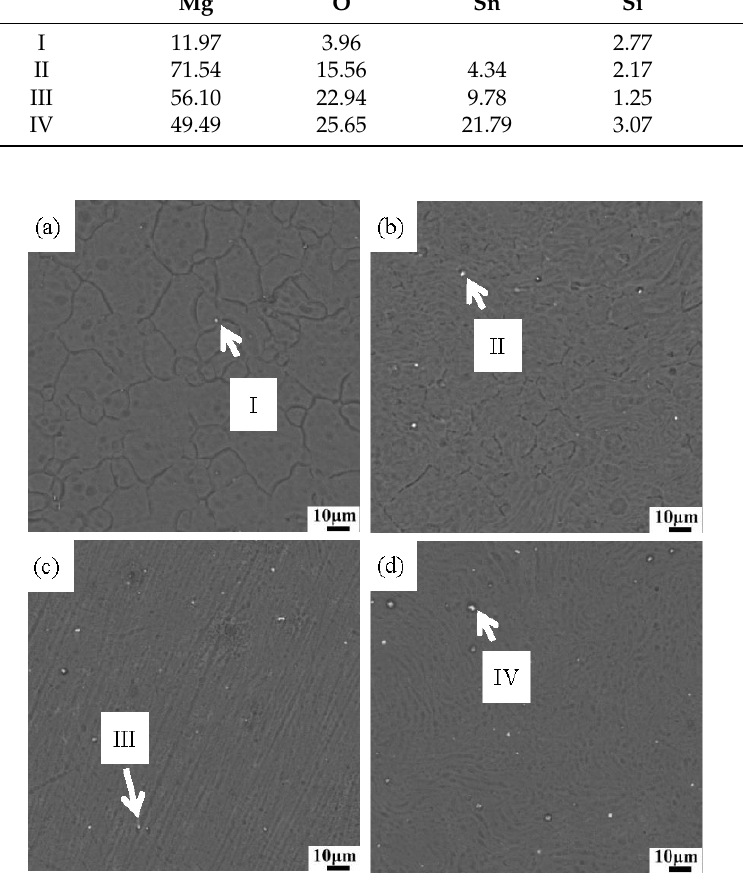
Figure 1. Microstructures of Mg-1Zn-based alloys: Mg-1Zn ( a ), Mg-1Zn-1.0Sn ( b ), Mg-1Zn-1.5Sn ( c ), and Mg-1Zn-2.0Sn ( d ). Table 1. Chemical compositions of the white particles in Mg–1Zn-based alloys (wt.%).